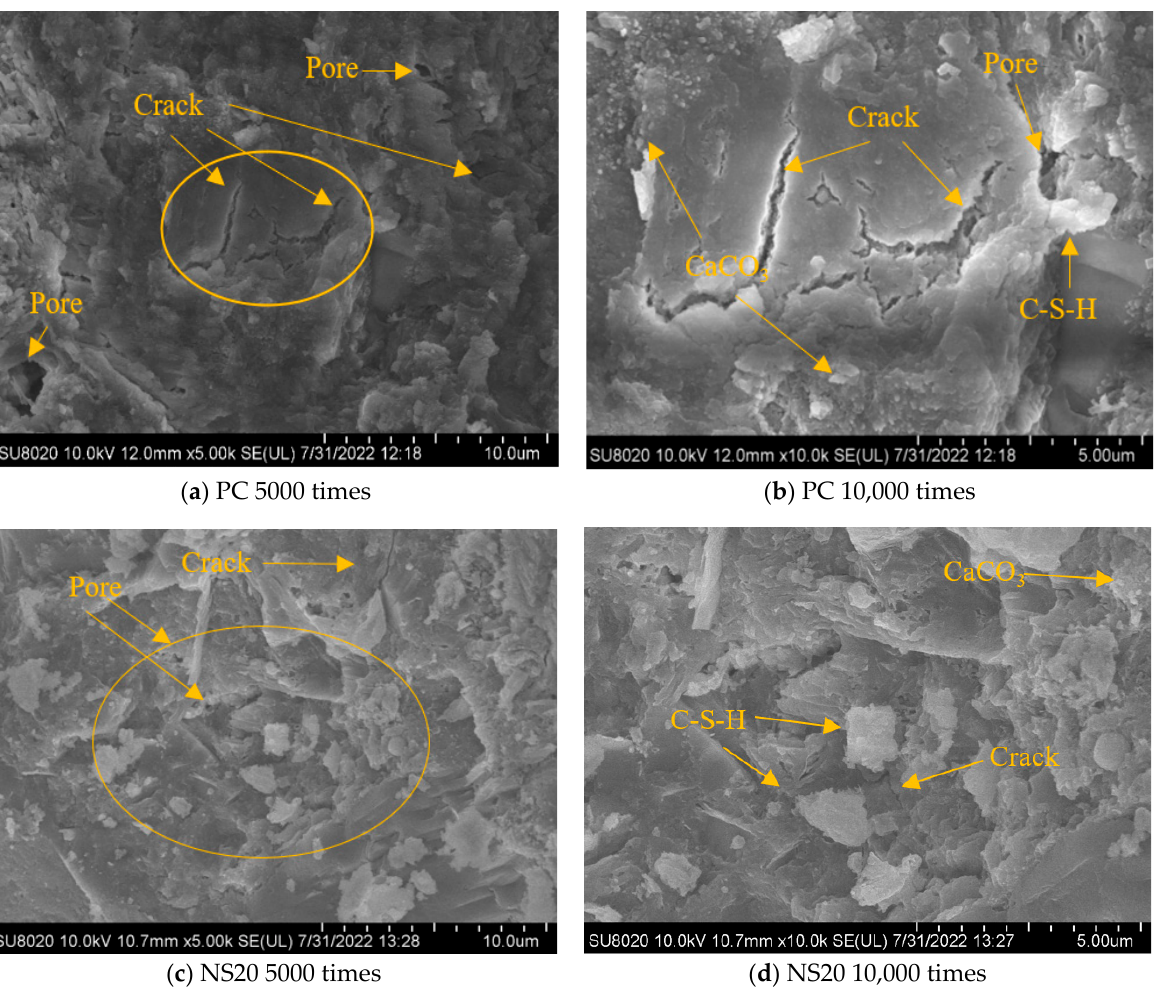
Figure 7. SEM diagram of the concrete tensile zone’s interface transition zone (stress level 0.6, age 28 days).